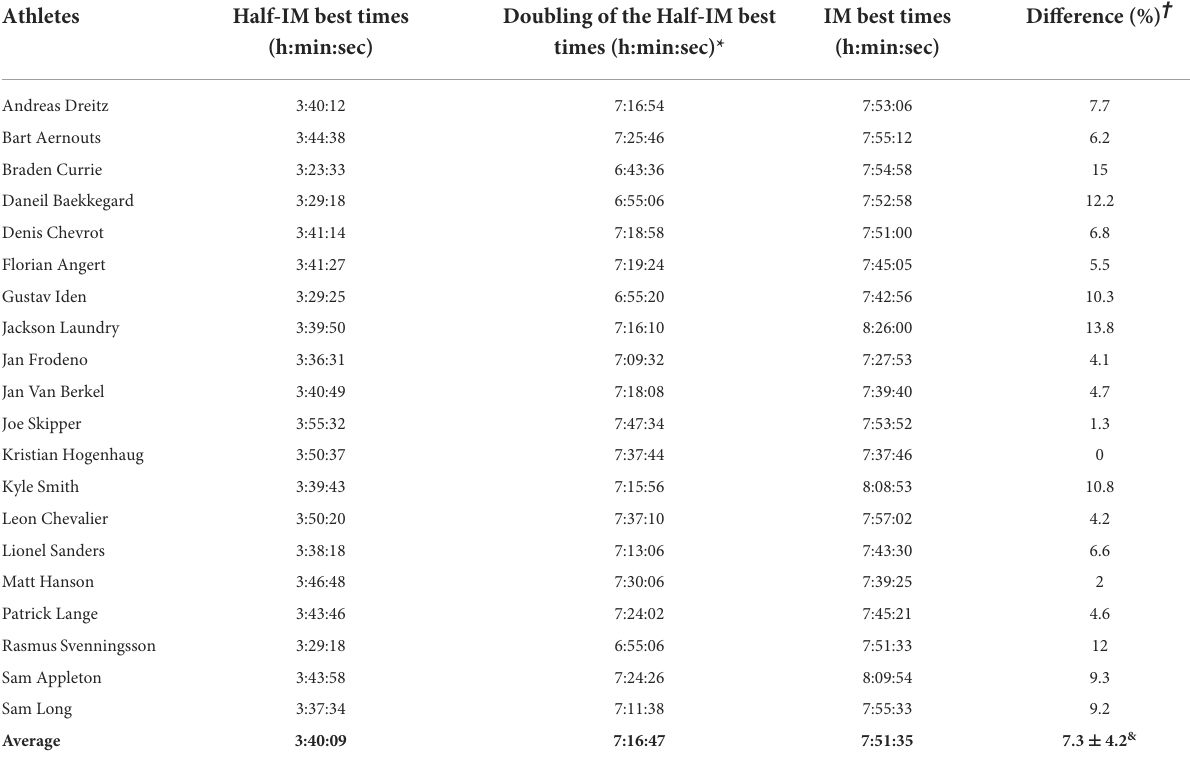
TABLE 3 Comparison of the fastest half-Ironman TM and Ironman TM triathlons of some of the best current long-distance triathletes in the world. Athletes Half-IM best times Doubling of the Half-IM best